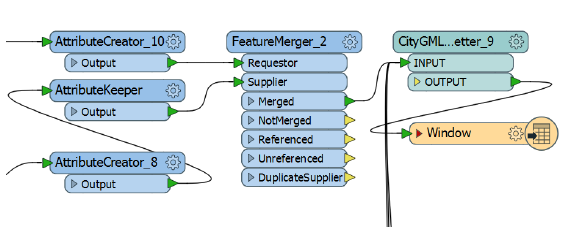
Figure 11: Algorithm of semantic mapping of Windows The model is enriched with attributes in accordance with the CityGML Standard, such as gml_name, class, function and